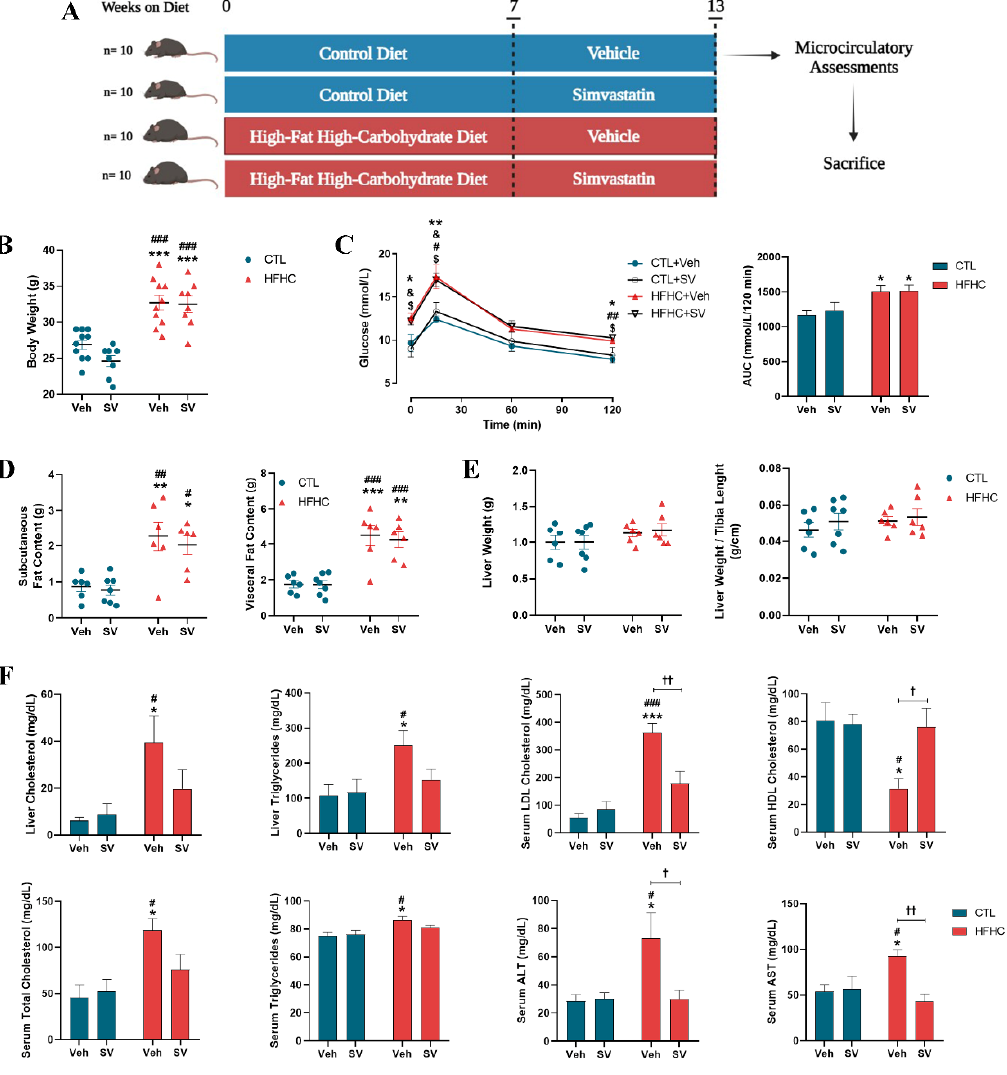
Figure 1. SV protects against nonalcoholic fatty liver disease (NAFLD)-induced metabolic changes. Schematic representation of the experimental protocol used to assess the effect of SV on NAFLD ( A ). Hemodynamic and metabolic parameters of mice fed control diet (CTL+Veh), control diet plus SV (CTL+SV), high-fat–high-carbohydrate (HFHC) diet (HFHC+Veh), or HFHC diet plus Simvastatin treatment (HFHC+SV) are show as: Body weight ( B ), fat content ( D ), liver weight ( E ) and biochemical parameters ( F ). * p < 0.05 vs. CTL+Veh; ** p < 0.01 vs. CTL+Veh; *** p < 0.001 vs. CTL+Veh; # p < 0.05 CTL+SV; ## p < 0.01 CTL+SV; ### p < 0.001 vs. CTL+SV; † p < 0.05 HFHC+SV; †† p < 0.01 HFHC+SV. Oral glucose tolerance test (OGTT) is demonstrated in ( C ). Area under the curve (AUC) of glucose was calculated using the trapezoidal rule ( C ). * p < 0.05 CTL+Veh vs. HFHC+Veh; ** p < 0.01 CTL+Veh vs. HFHC+Veh; # p < 0.05 CTL+Veh vs. HFHC+SV; ## p < 0.01 CTL+Veh vs. HFHC+SV; & p < 0.05 CTL+SV vs. HFHC+Veh; $ p < 0.05 CTL+SV vs. HFHC+SV.